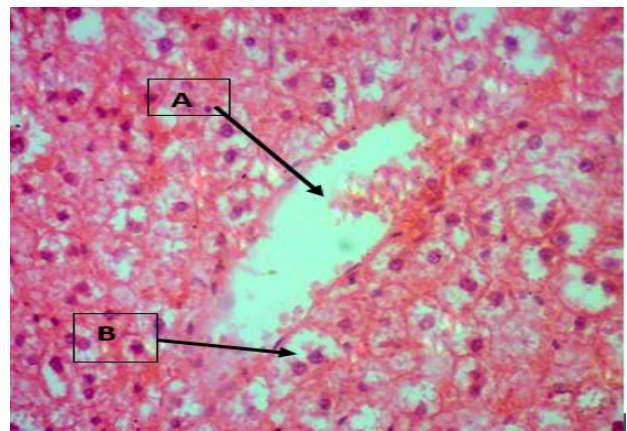
Fig. 4. Photomicrograph of rat liver showing markedly dilated central vein with hemorrhage (A) and balloon degeneration of hepatocytes (B) [ARS 100 group 100X].